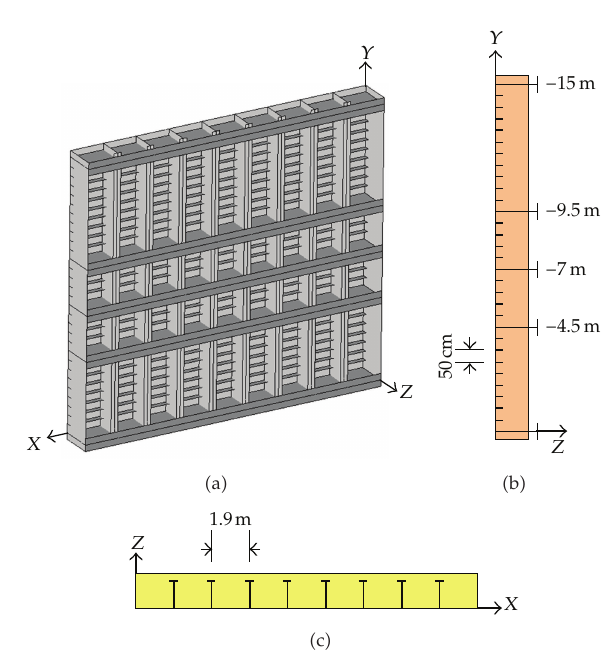
Figure 31: Numerical model of gate 2.